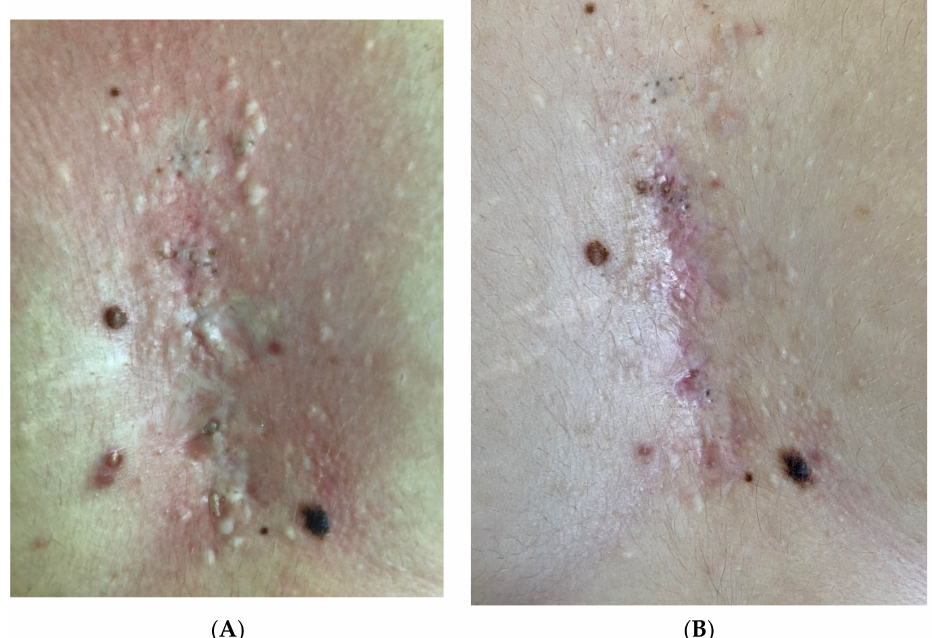
Figure 3. ( A ) Hidradenitis suppurativa atrophic/hypertrophic scar. ( B ) After four sessions performed with LWP-RF device at 0,6 watt energy and 3Hz frequency, breaking down the edges and stimulating the rise of the central skin depression, an improvement of atrophy was observed. Moreover a reduction of thickness and a improvement of texture of the hypertrophic parts of the scars treated with four session at 0,6 watt energy and 3Hz frequency, with detached spots of sublimation to get the shrinkage, were also